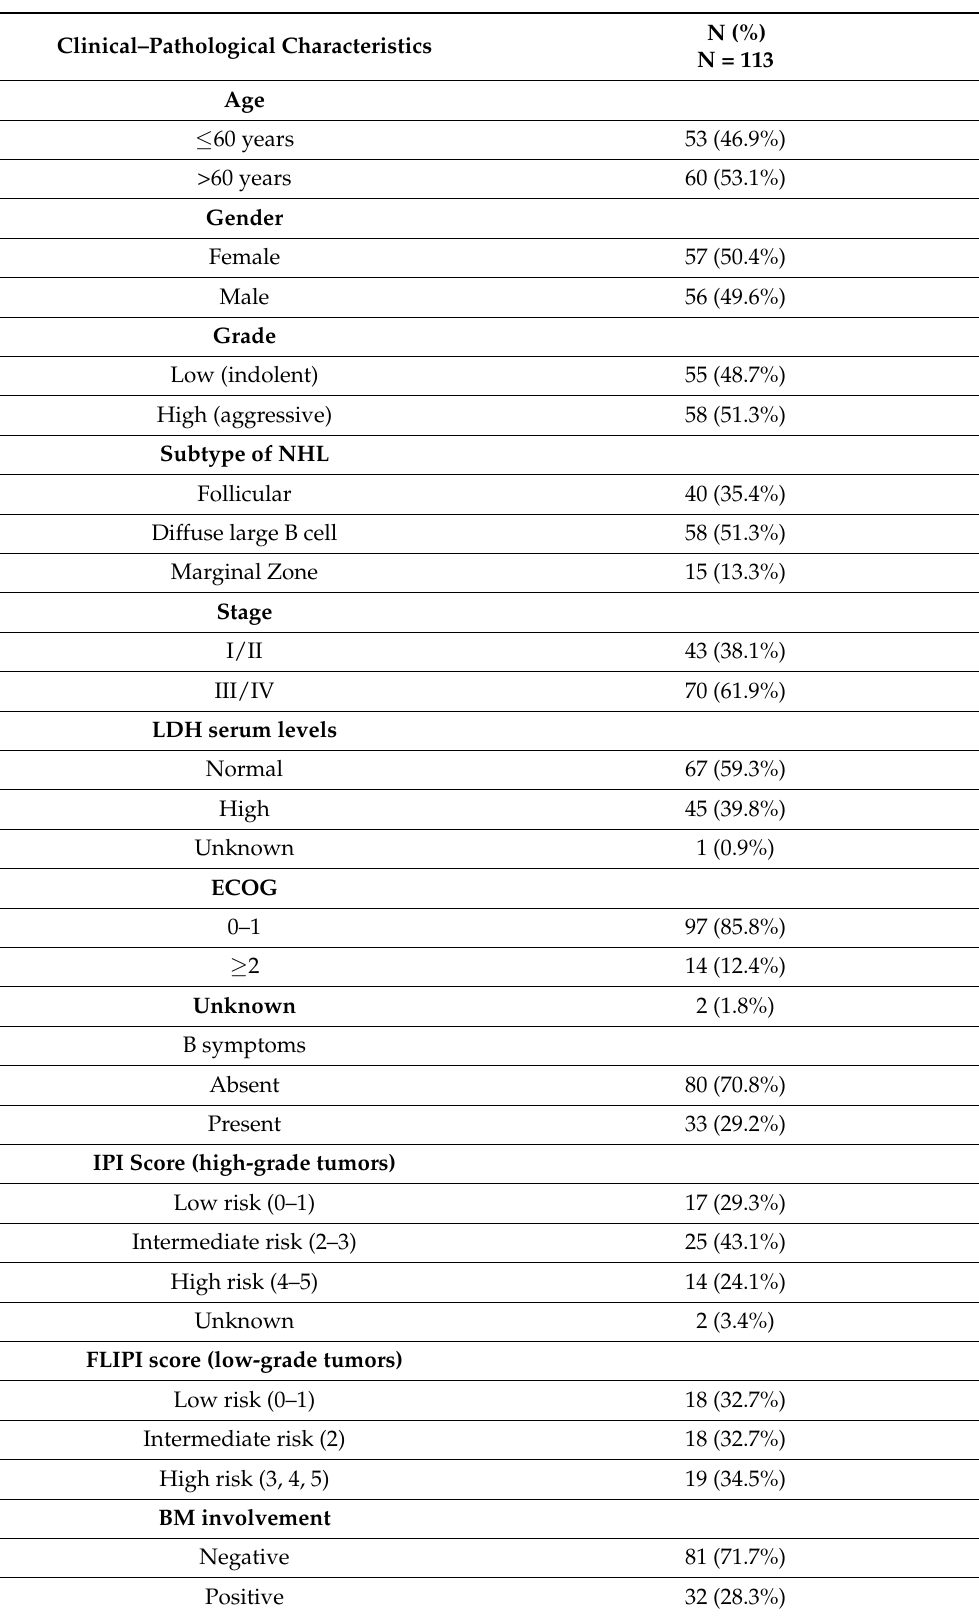
Table 1. Patients’ clinicopathologic